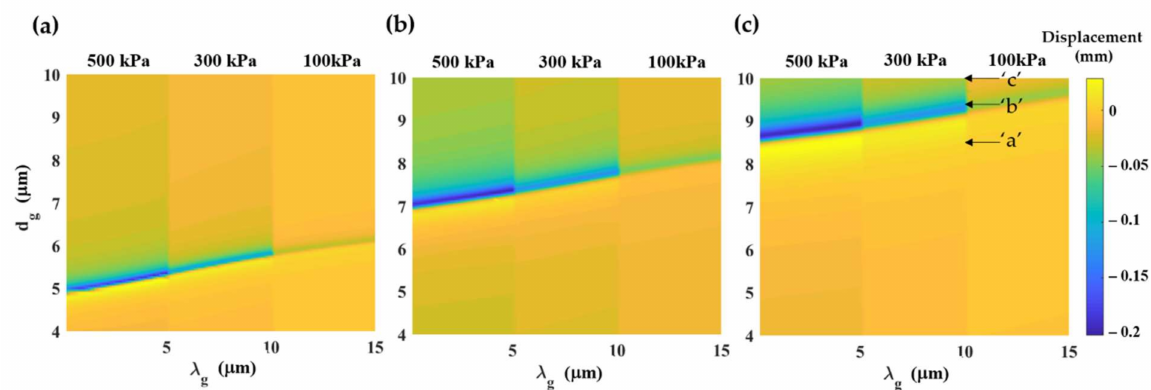
Figure 3. Grating thickness compression in µ m calculated using the FEM simulation for different grating structures with d of 11 µ m with a varying grating thickness (shown in y-axis) from 4 µ m to 11 µ m and a varying grating period (shown in x-axis) from 0 µ m to 15 µ m, and ( a ) F.F. of 0.99, ( b ) F.F. of 0.98, and ( c ) F.F. of 0.97 under 2 MHz ultrasonic pressures of 500 kPa, 300 kPa, and 100